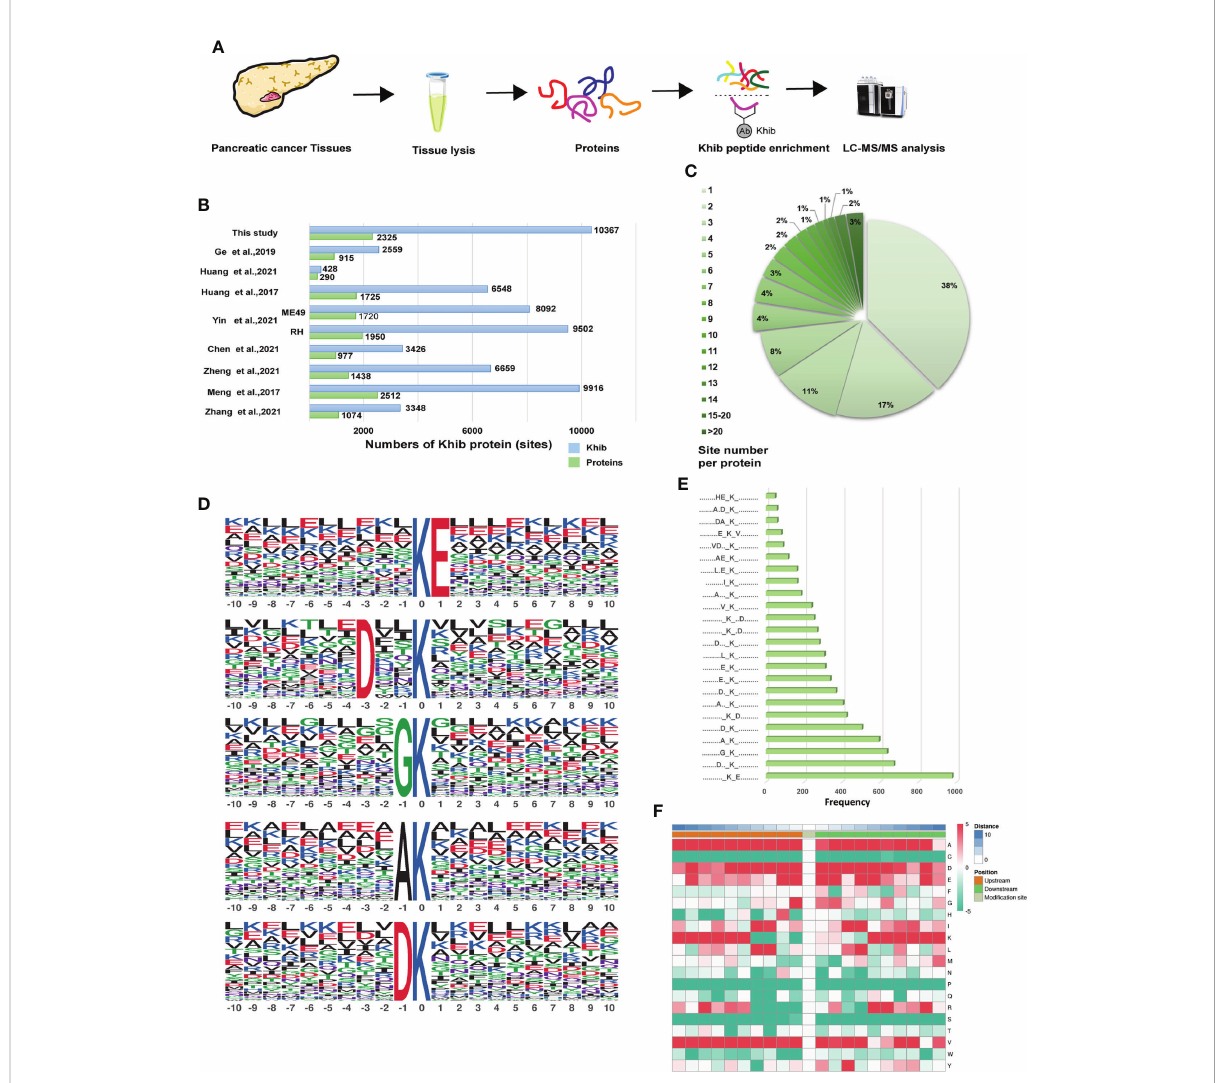
FIGURE 2 Genome-wide identity and pro fi ling of the K hib proteins and sites in PC. (A) Work fl ow for the identi fi cation of K hib modi fi cation in PC. Proteins extracted from the PC tissues were digested into peptides, and then the speci fi c K hib antibody enriched the K hib sites-containing peptides, followed by the liquid chromatography with tandem mass spectrometry (LC-MS/MS) analysis. (B) Comparison of the K hib proteins and sites identi fi ed in our study and those in previous reports. (C) Numbers and ratios of K hib sites for each protein. (D) The top fi ve K hib motifs. The size of each letter indicates the frequency of that amino acid residue at that position. (E) Frequency of occurrence of each motif among the peptides with K hib modi fi cations. (F) The heatmap of the amino acid pro fi le of the K hib sites, featuring the enrichment (red) and depletion (green) of the amino acids at every position (from -10 to +10) on both sides of the K hib